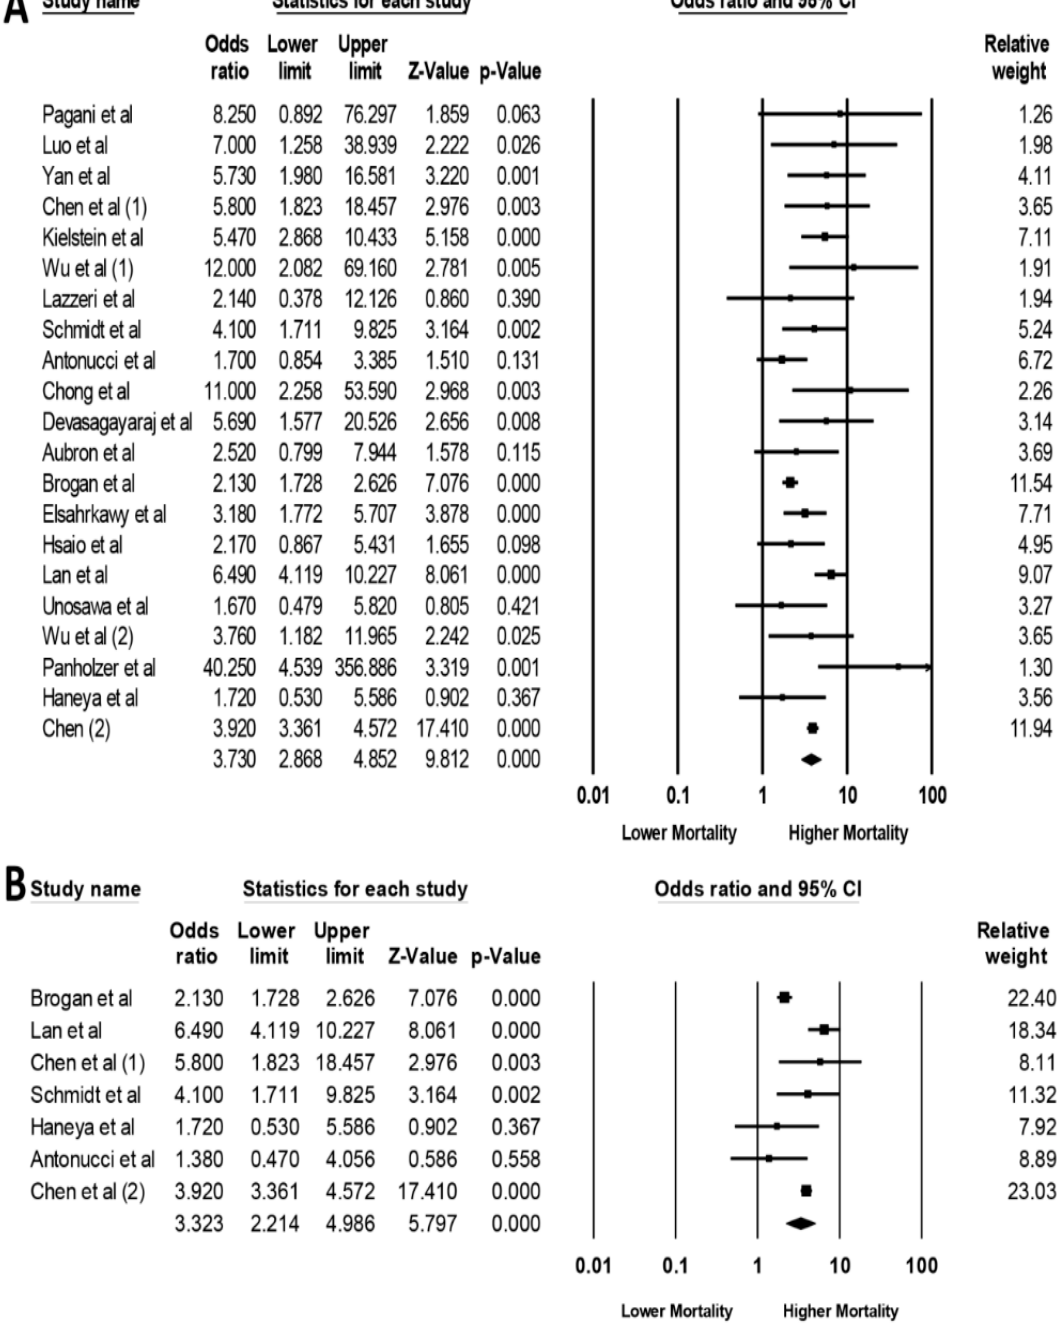
Figure 5. Forest plots of the included studies assessing ( A ) hospital mortality among patients receiving ECMO with AKI on RRT and ( B ) hospital mortality among patients receiving ECMO with AKI on RRT limited to studies with confounder-adjusted analysis. A diamond data label serves as the overall rate from each included study (square data marker) and 95%CI.